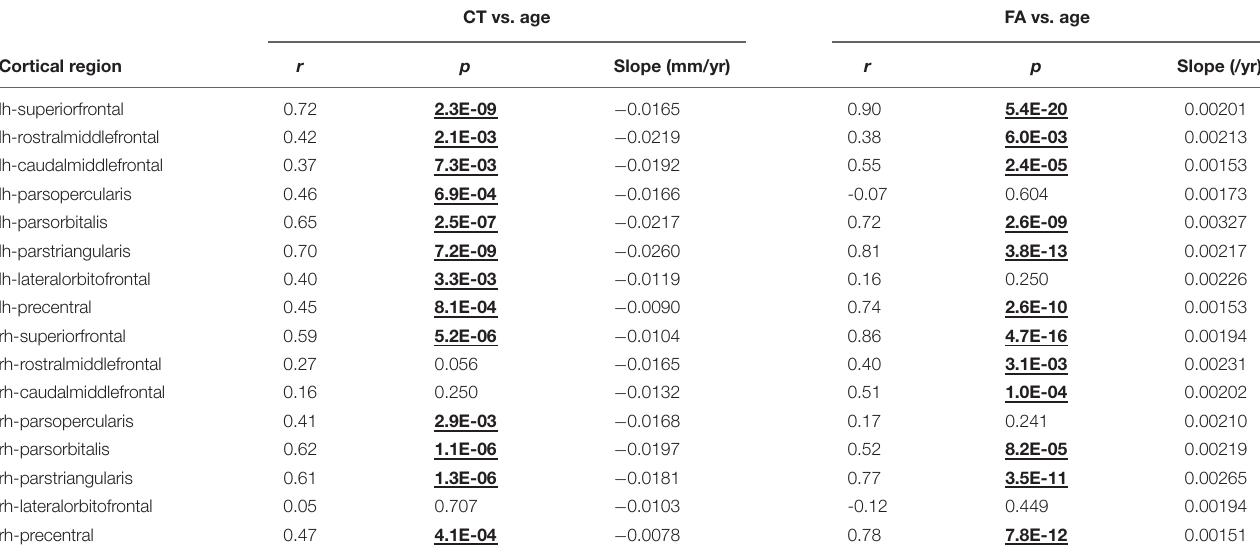
The underlined bold indicates p < 0.05 after FDR